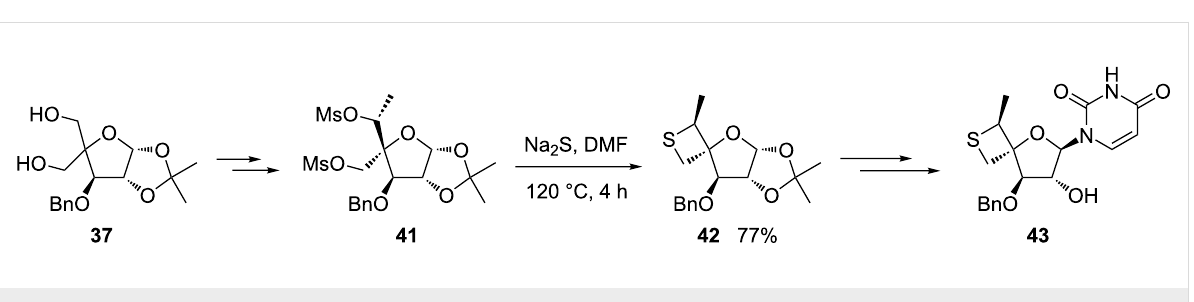
Scheme 9: Synthesis of optically active 2-methylthietane-containing spironucleoside 43 .